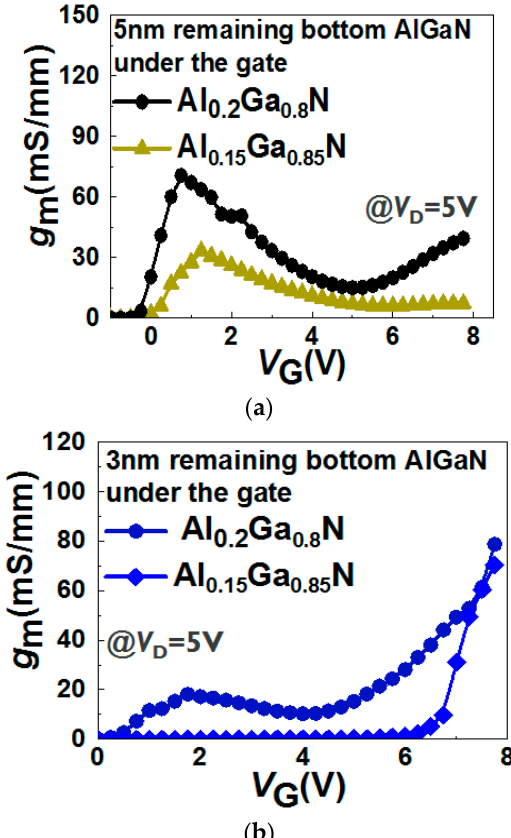
Figure 10. g m – V G characteristics in the devices with a ( a ) 5 nm or ( b ) 3 nm remaining bottom AlGaN layer under the gate region with different Al% in the bottom AlGaN barrier.